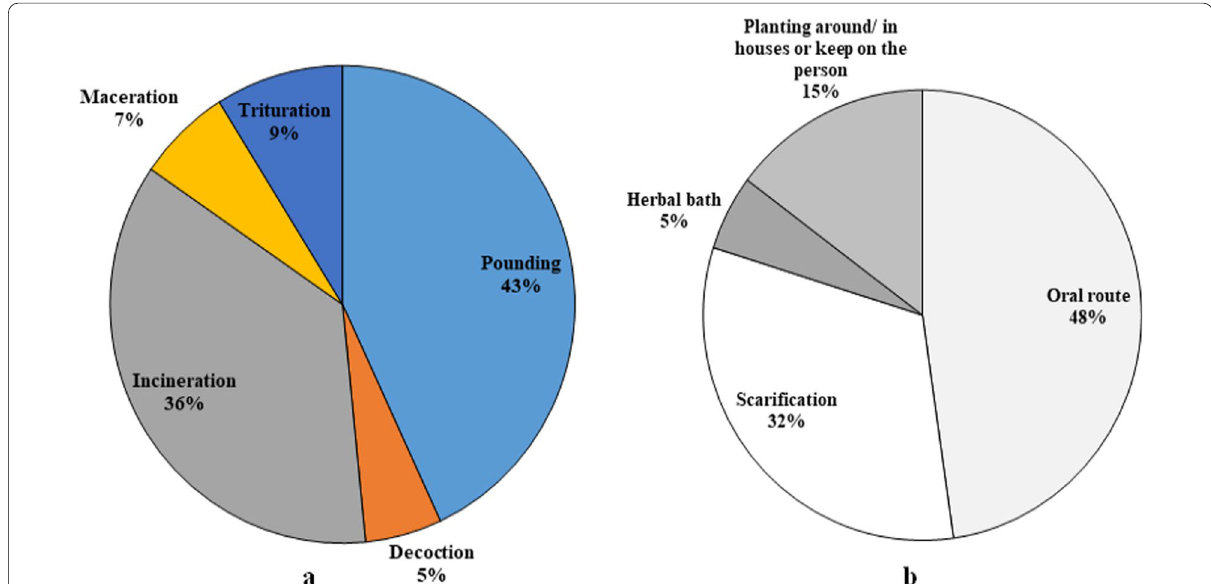
Fig. 5 Methods of a preparation, and b administration of anti-snakebite recipes in Bénin